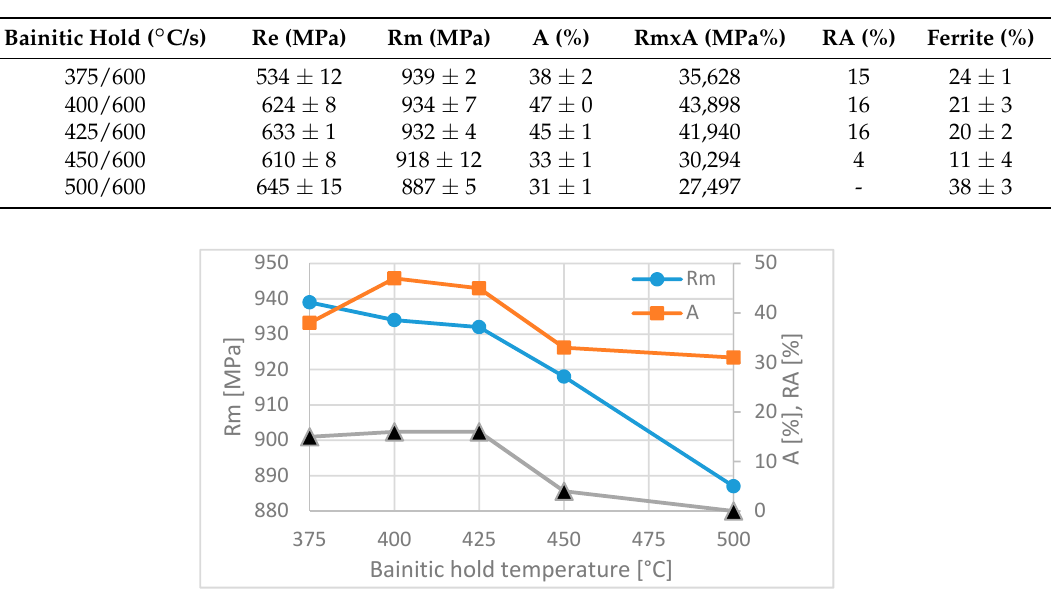
Figure 10. Effect of bainitic hold temperature on tensile strength (Rm), total elongation (A) and retained austenite (RA).